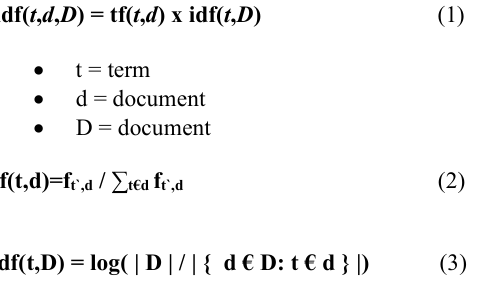
Fig. 1. Block Diagram of System.